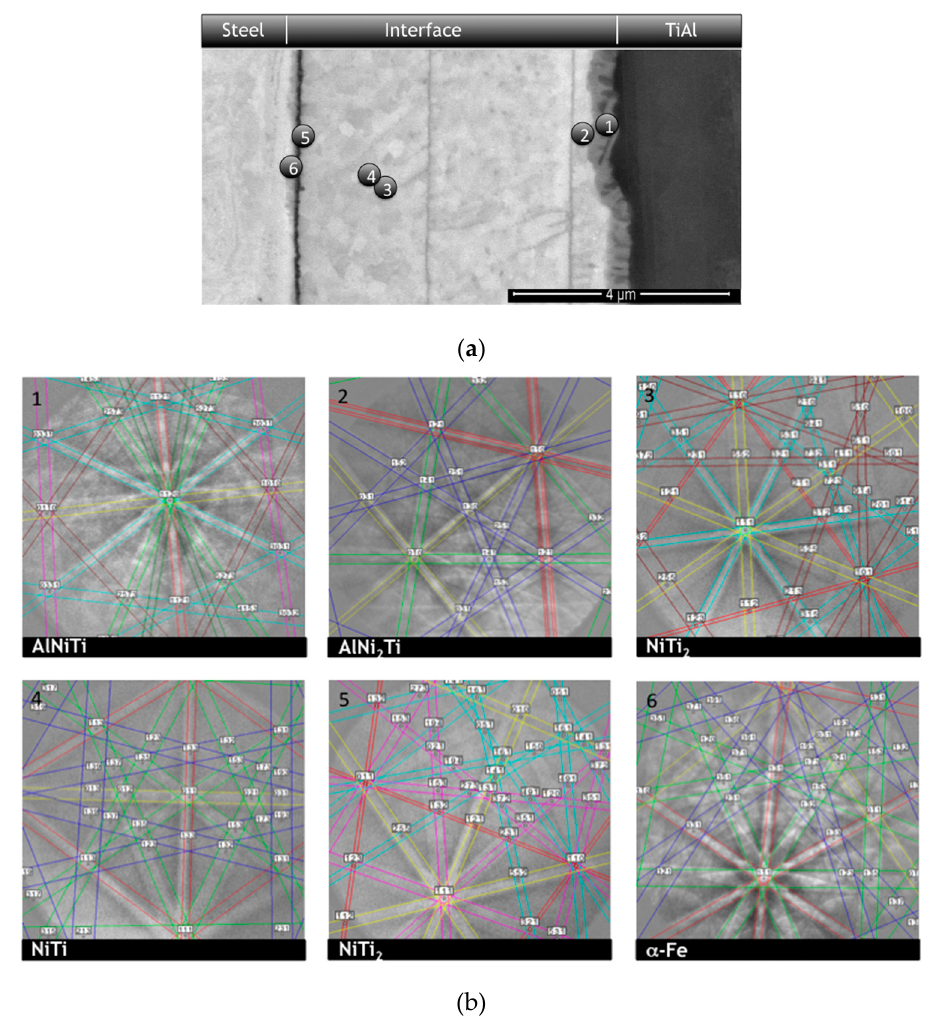
Figure 3. ( a ) SEM images of the TiAl/steel joints produced at 800 °C under a pressure of 10 MPa and ( b ) EBSD Kikuchi pattern indexation of the zones marked in ( a ).